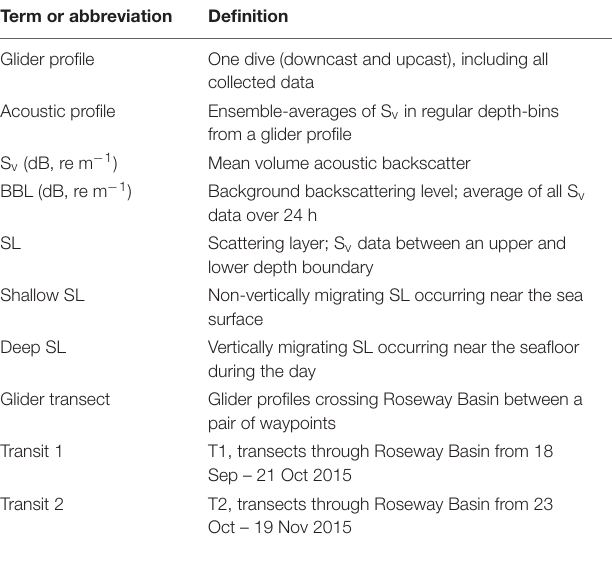
TABLE 1 | Definitions of terms and abbreviations used in the